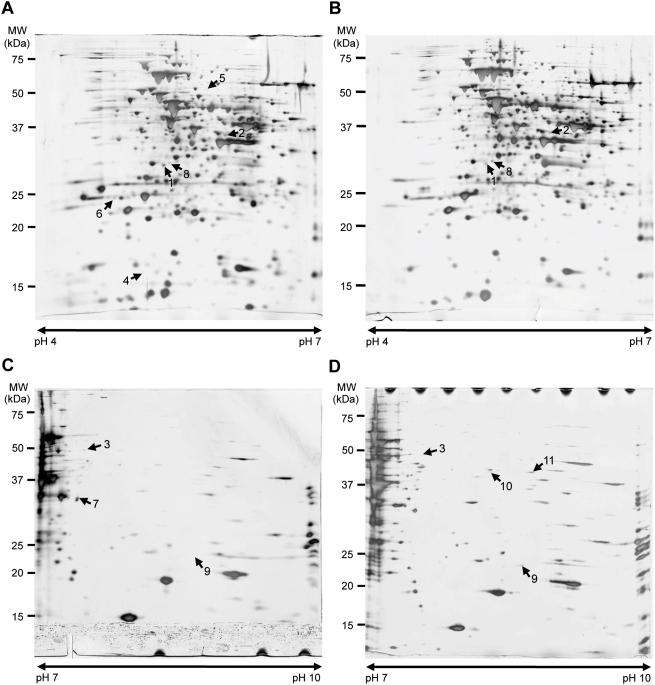
2D gel electrophoresis patterns of proteins extracted from L. hongkongensis HLHK9 cells grown at 20°C and 37°C.Comparison of soluble proteins from L. hongkongensis HLHK9 grown at (A) 20°C and (B) 37°C in the pH range of 4–7 and (C) 20°C and (D) 37°C in the pH range of 7–10. The arrowheads indicate spots with differential expression. Molecular masses (MW) and pH are indicated.